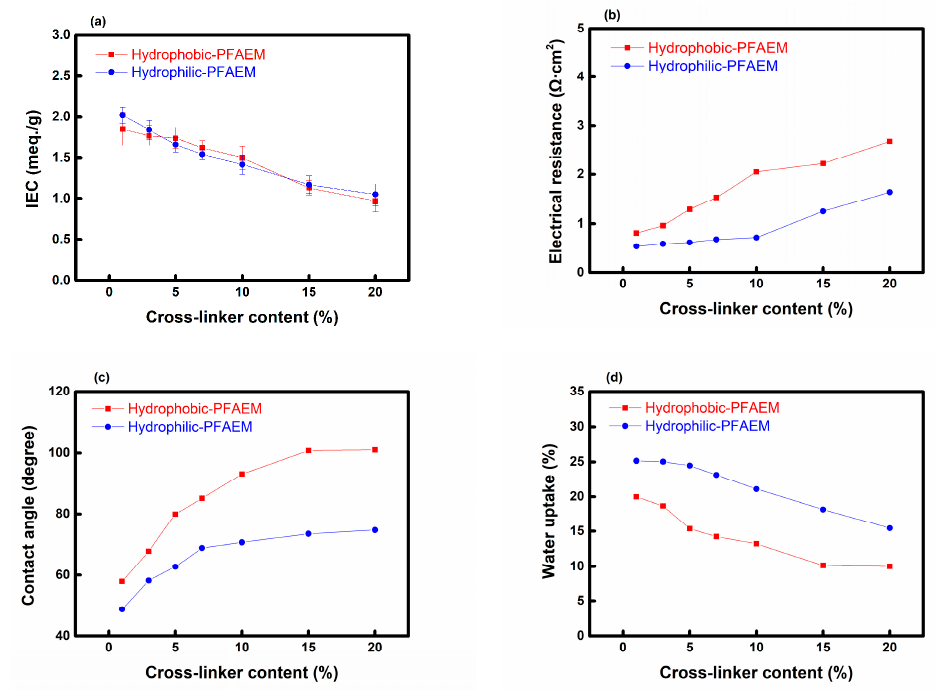
Figure 4. Changes in ( a ) IEC values, ( b ) electrical resistances (measured in a 0.5 M NaCl), ( c ) surface contact angles, and ( d ) water uptake of the PFAEMs by varying the content of cross-linking agent, divinylbenzene (DVB).